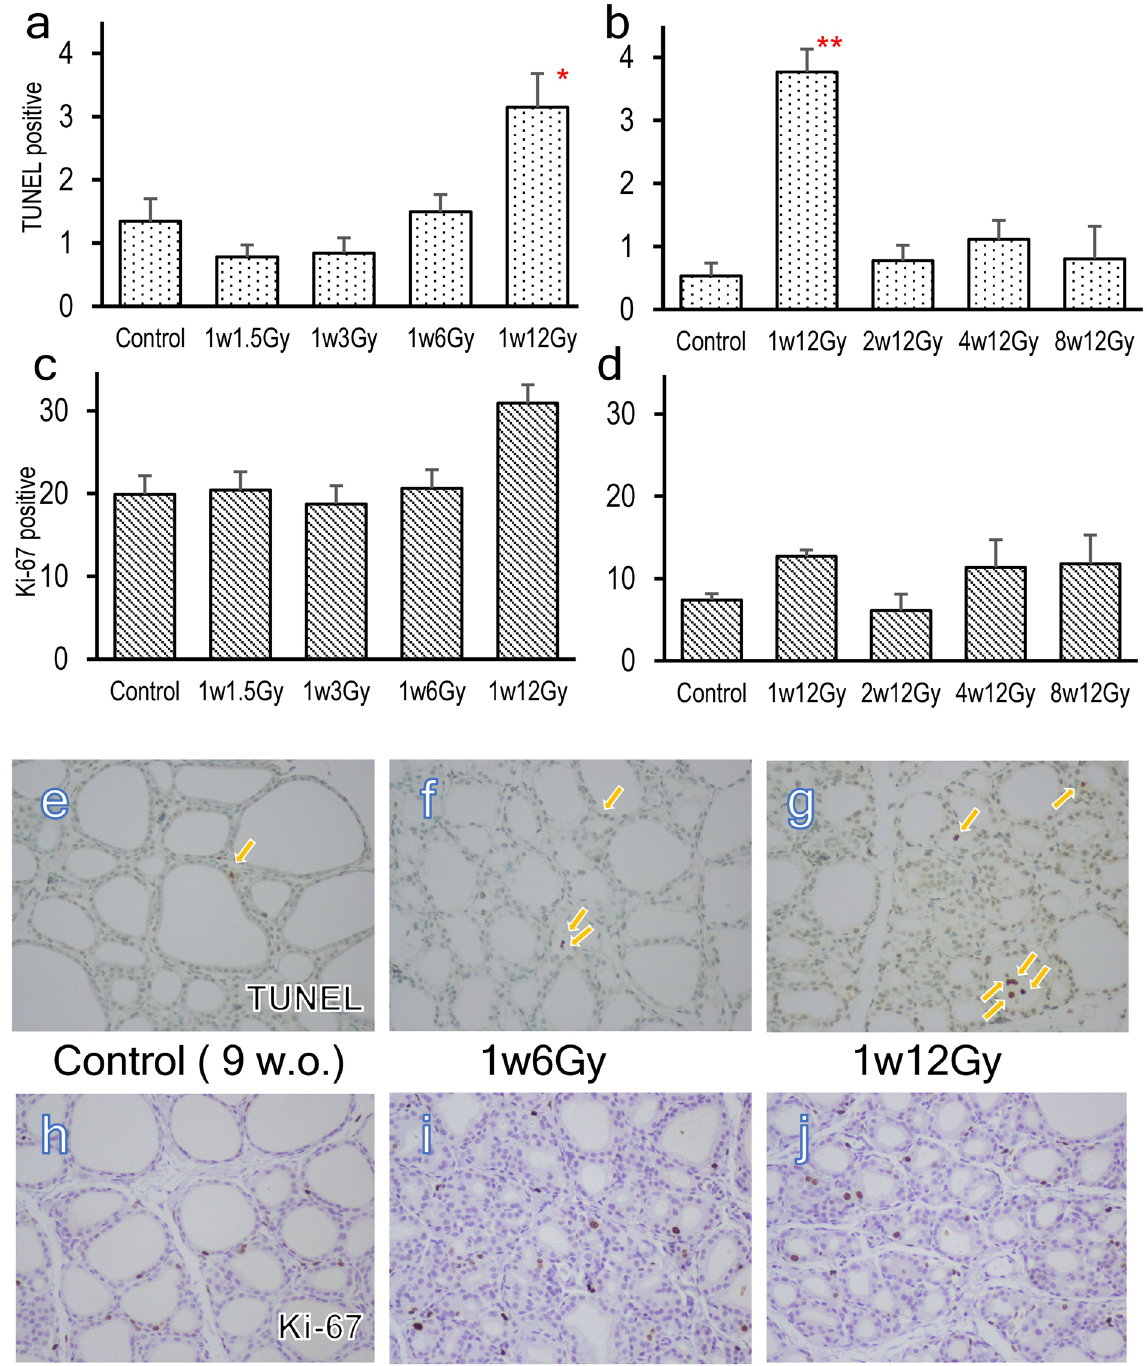
TUNEL positive staining. ** indicates significant difference from Control (* p < 0.05, ** p <